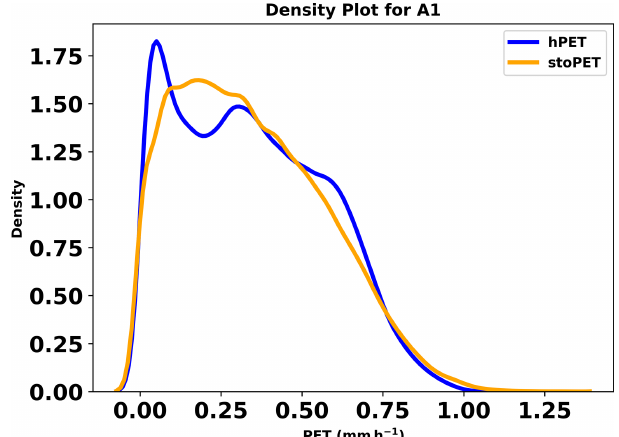
Figure 11. Density plots for hPET and stoPET for the arid location in North America (for A1 in Fig. 7). The data represent the daytime hourly PET from 2001 to 2020.